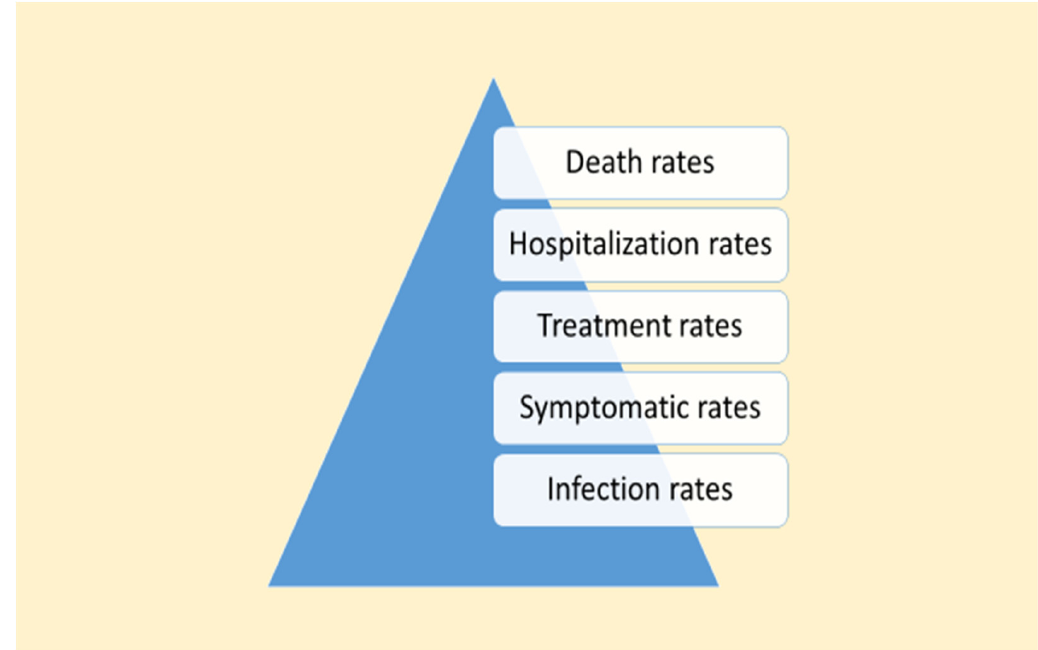
Figure 1. Degree of severity in COVID-19 illness (Yang et al. 2020).